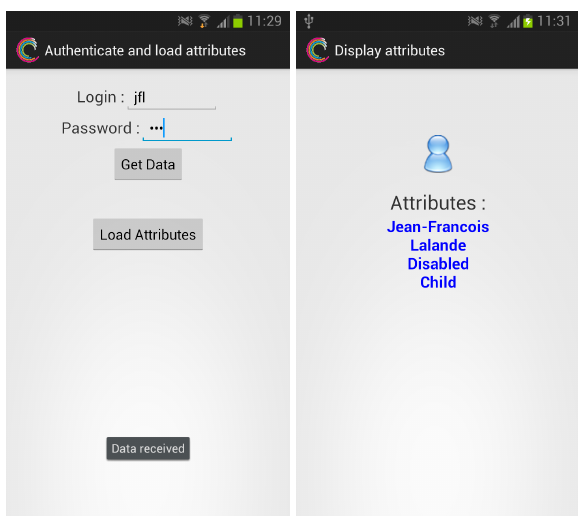
Figure 4. Loading attributes into the cardlet.